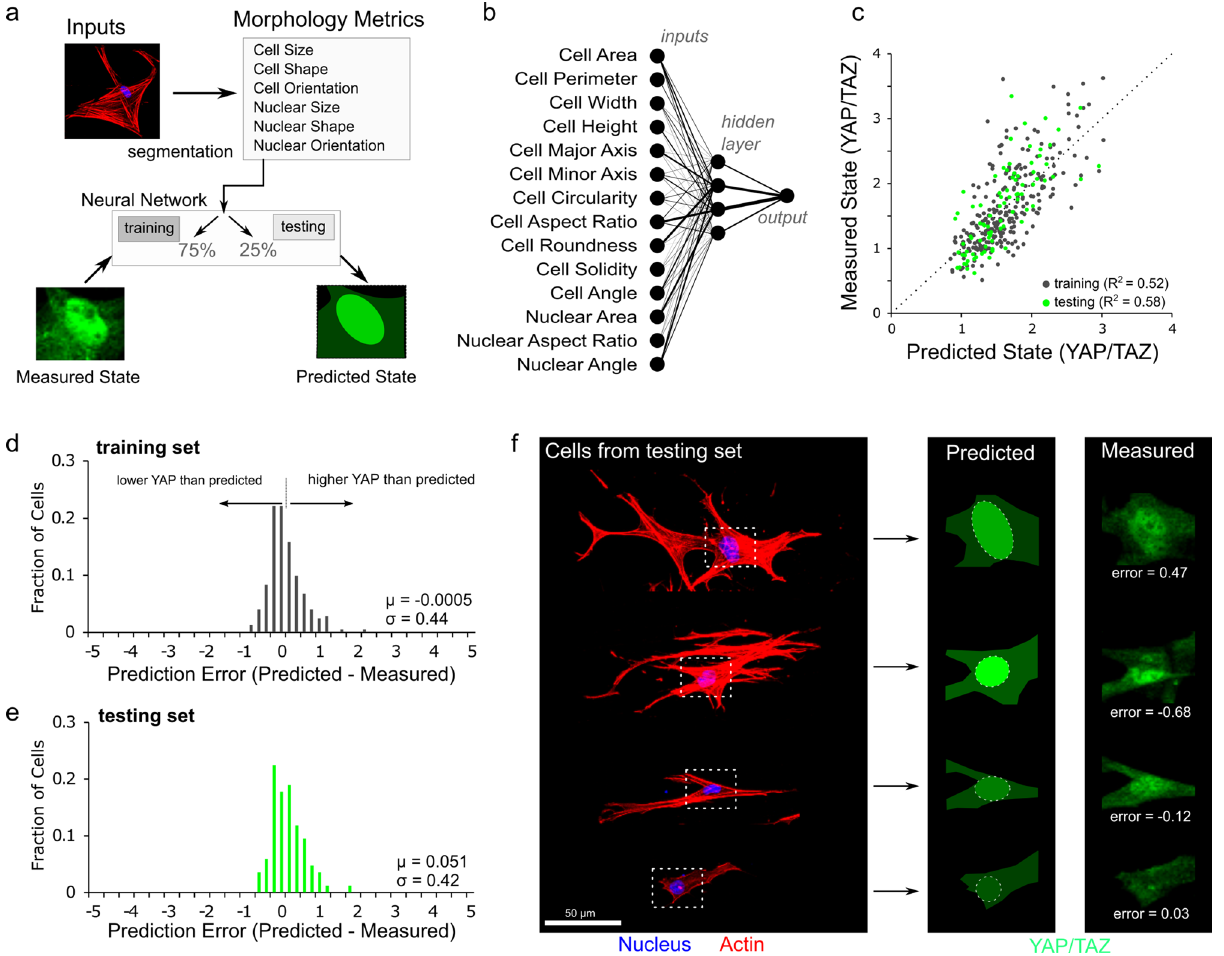
Figure 2. A neural network uses cell morphology to predict mechanobiologic state. ( a ) A neural network was constructed by segmentation of individual cells to quantify cell and nuclear size, shape, and orientation and trained by Bayesian regularization based on measured YAP/TAZ levels. ( b ) The neural network consisted of 14 inputs and a 4 neuron hidden layer to predict the nuclear/cytoplasmic ratio of YAP/TAZ. ( c ) Both training and testing data sets maintained predictability with R 2 between predicted and measured states above 0.5. Error histograms for training ( d ) and testing ( e ) sets were centered close to zero error (µ train = − 0.0005 and µ test = 0.051) with associated standard deviations of σ train = 0.44 and σ test = 0.42. ( f ) Predicted values for cells from the testing set provide a visual depiction of different error systematically over (μ < 0) or under (μ > 0) predicts YAP/TAZ levels, and the standard deviation (σ) of the errors describes precision of the predictions. Further, these errors can be visualized by constructing prediction images